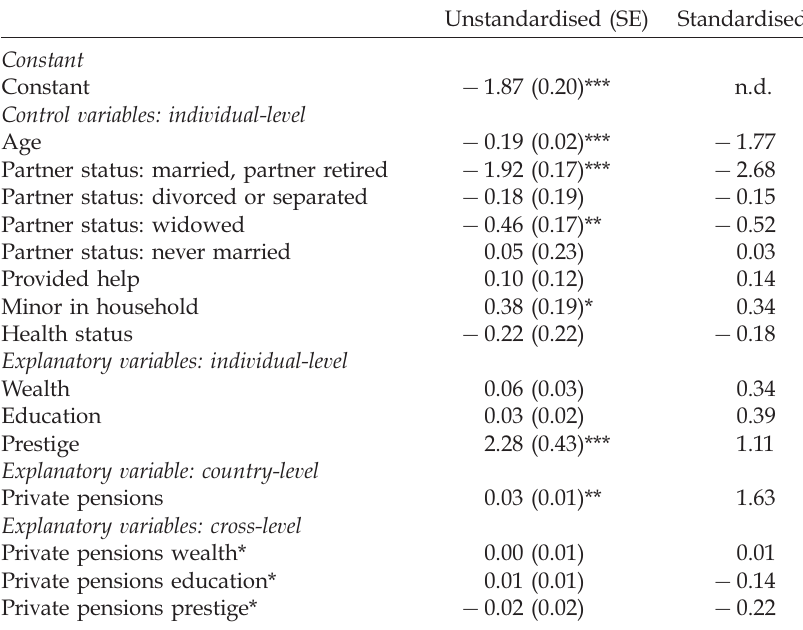
Table 4. Older women’s workforce participation: regression coefficients and standard errors